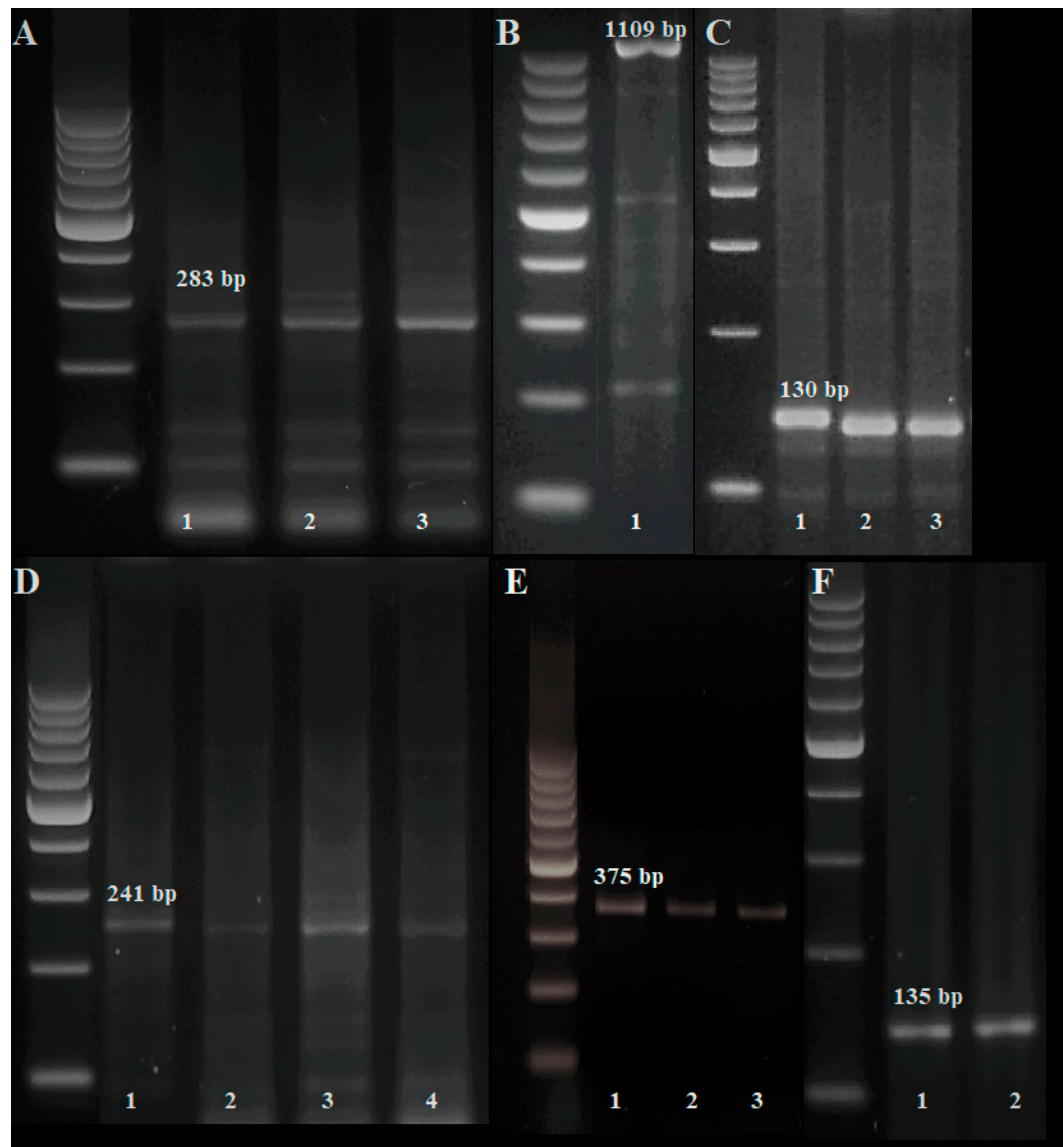
Figure 4. Identification of Pm gene markers in exemplary genotypes. Key: A ( Pm2a ): lane 1—S10, lane 2—cv. Zebra, lane 3—Z × S11 (breeding line 11), B ( Pm3d ): lane 1—cv. Zebra, C ( Pm4a ): lane 1—S11, lane 2—Z × S11 (breeding line 11), lane 3—Z × S12 (breeding line 12 ″ ), D ( Pm4b ): lane 1—S10, lane 2—